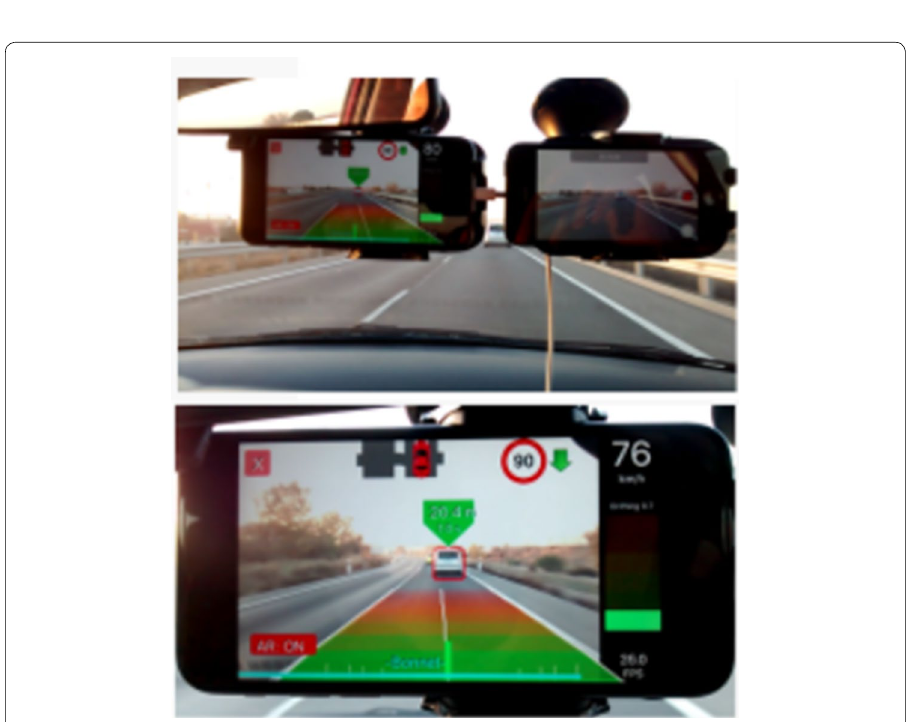
Fig. 2 Video-recorder using DriveSafe app on one of the testers’ windshield